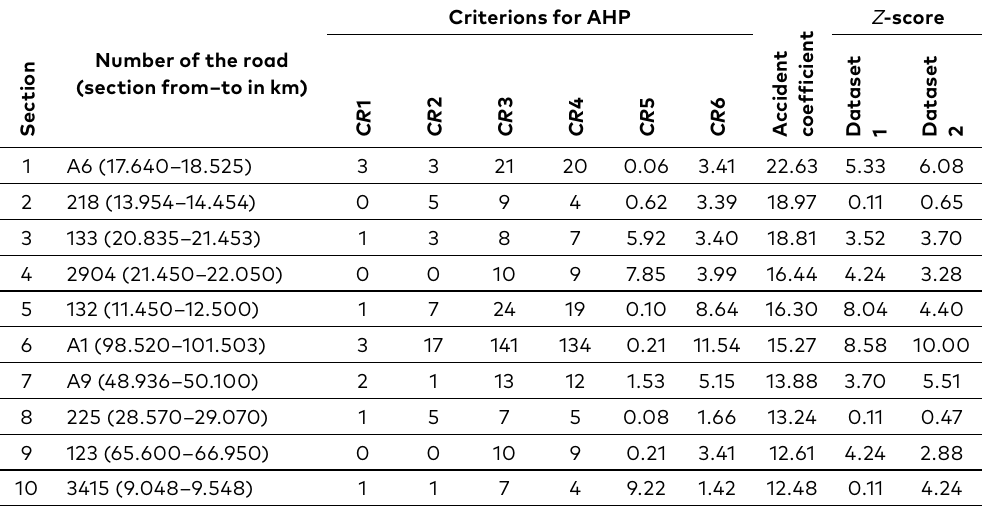
Table 3. Sections and criterions